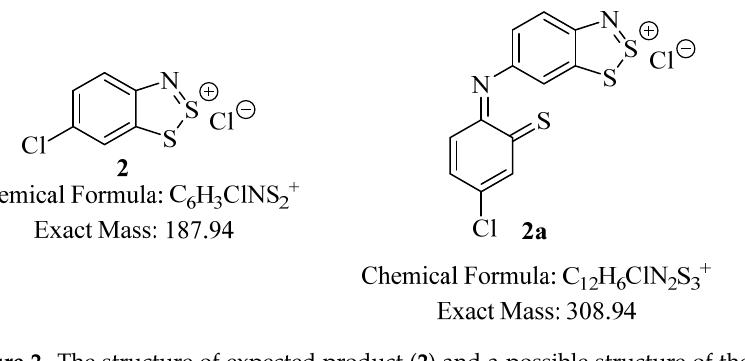
Figure 2. The structure of expected product ( 2 ) and a possible structure of the impurity detected by ASAP-MS.